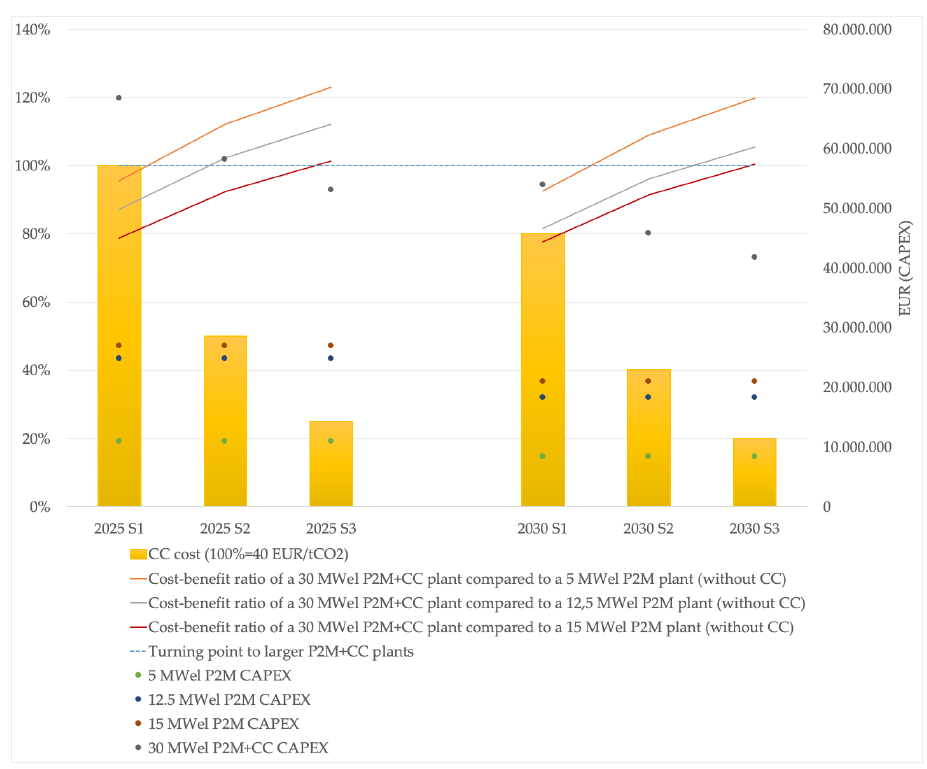
Figure 4. The role of carbon capture costs in choosing certain sites and plant sizes for decarbonization and renewable gas production with